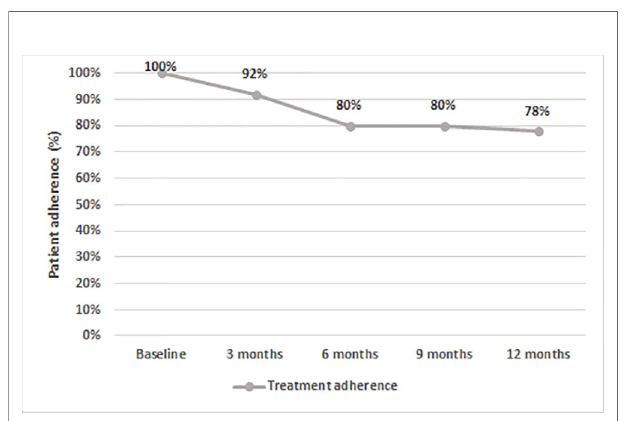
FIGURE 4 | Percentage of patients (N = 50) adherent to treatment throughout